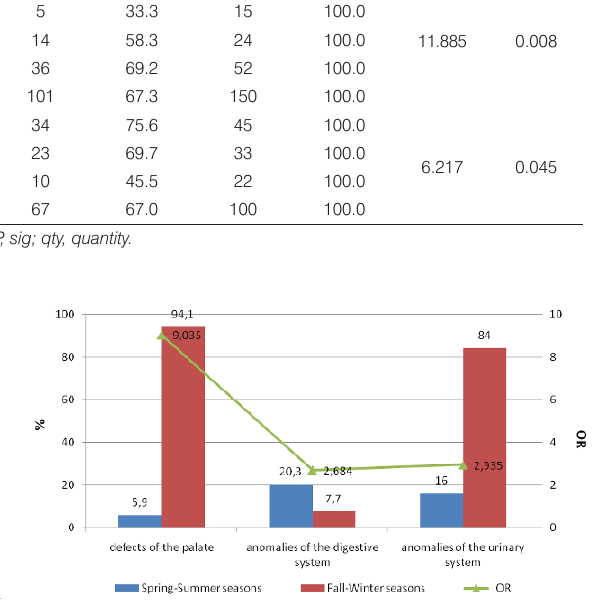
Figure 4. Relationships between the seasons of conception and associated abnormalities in fetuses with